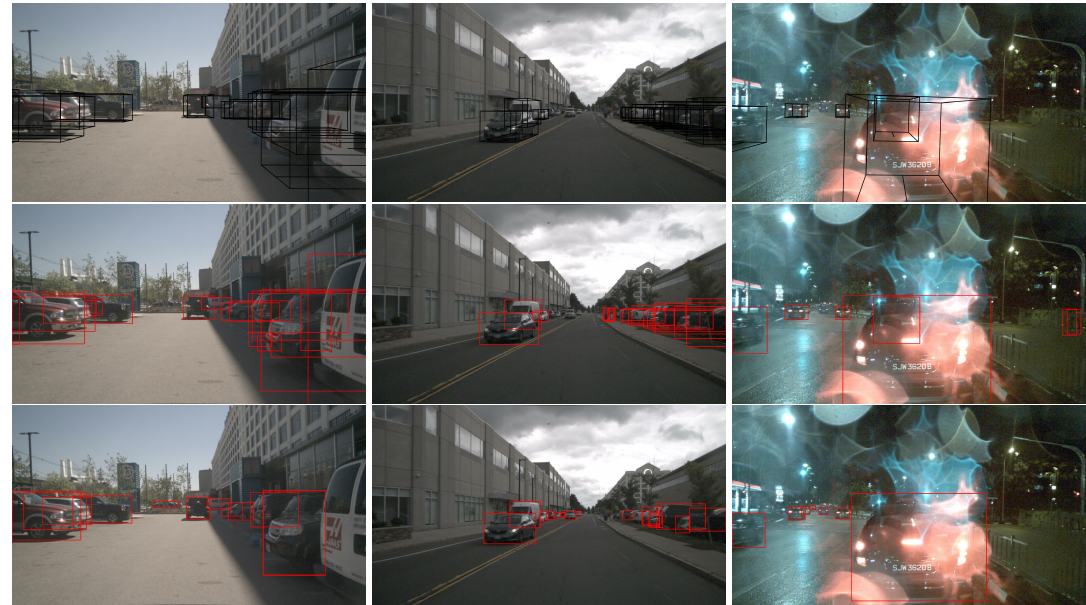
Figure 3. The annotations of front camera in nuScenes dataset [37]. Top row : the original annotations provided by the nuScenes, which are 3D bounding boxes colored by black. Middle row : the generated 2D annotations by converting the 3D bounding boxes. Bottom row : the 2D annotations generated by our proposed